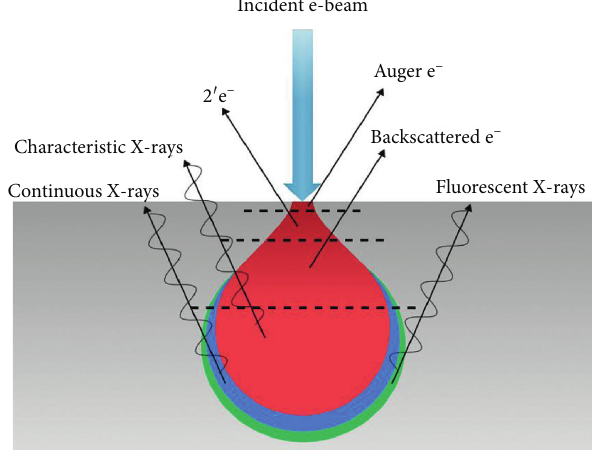
Figure 14: Illustration of sample-SEM signal interaction during analysis